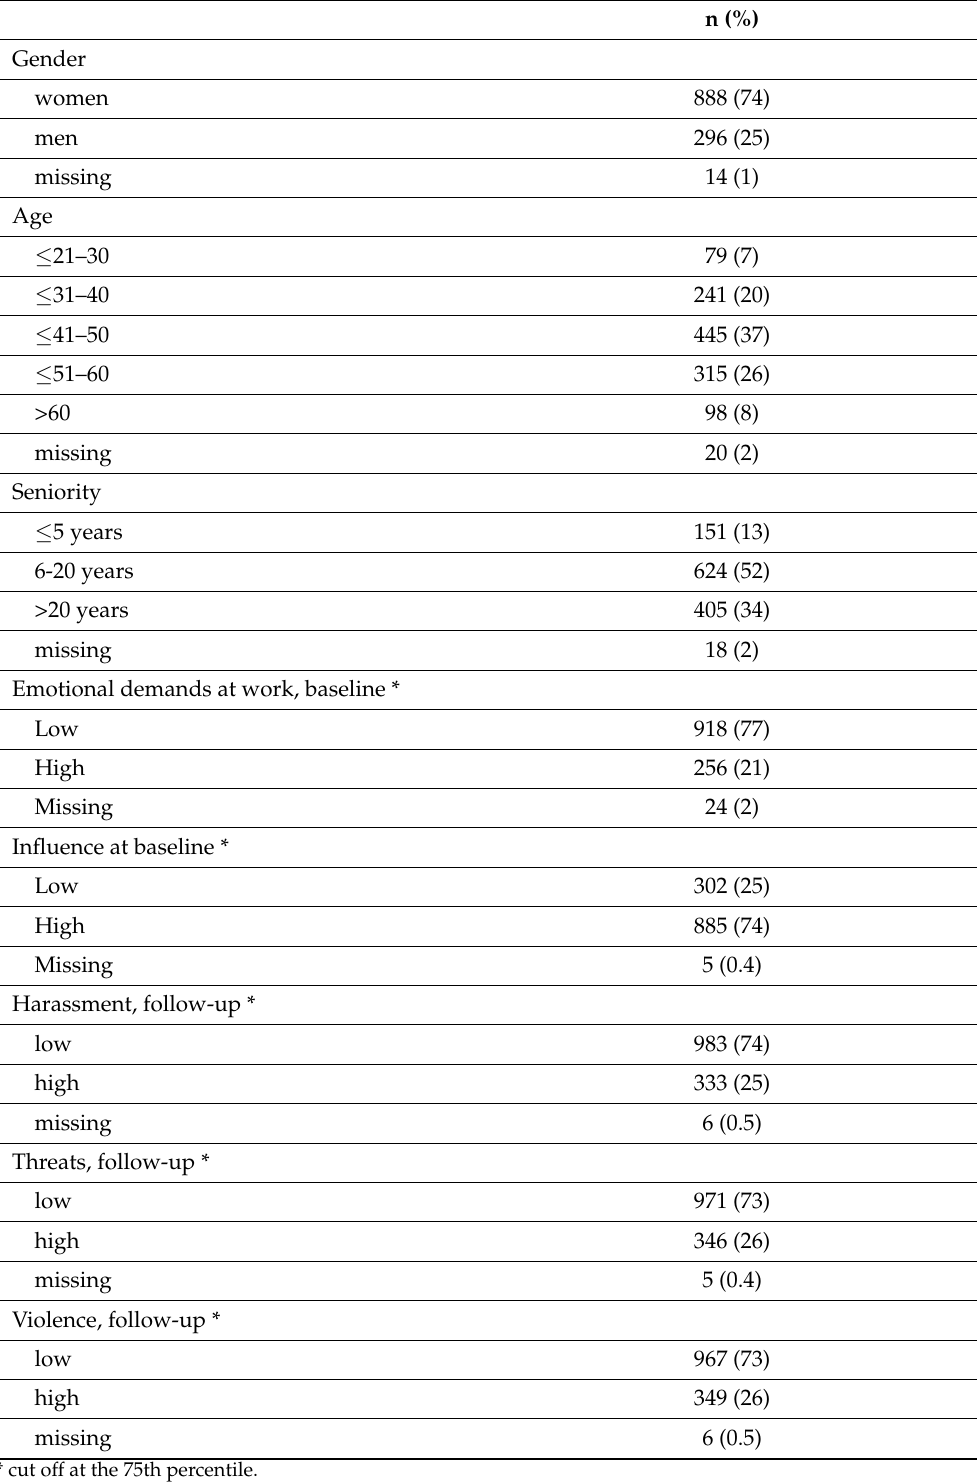
Table 1. Population characteristics, n =